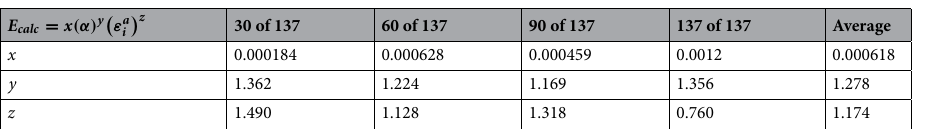
Table 2. Parameterized coefficients. Equation coefficients ( x , y , and z ) parameterized using either (a) 30, (b) 60, (c) 90 selected randomly among the organic compounds in Fig. S3 in the Supporting Information, or (d) all the compounds. The equations are correlated with polarizability and ionization